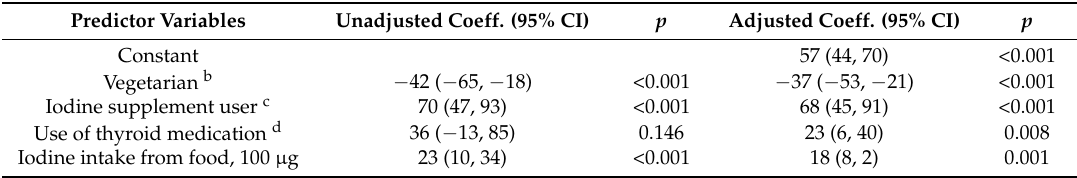
Table 3. Predictors for change in median urinary iodine concentration (UIC, µ g/L) a in young Norwegian women ( n = 403).